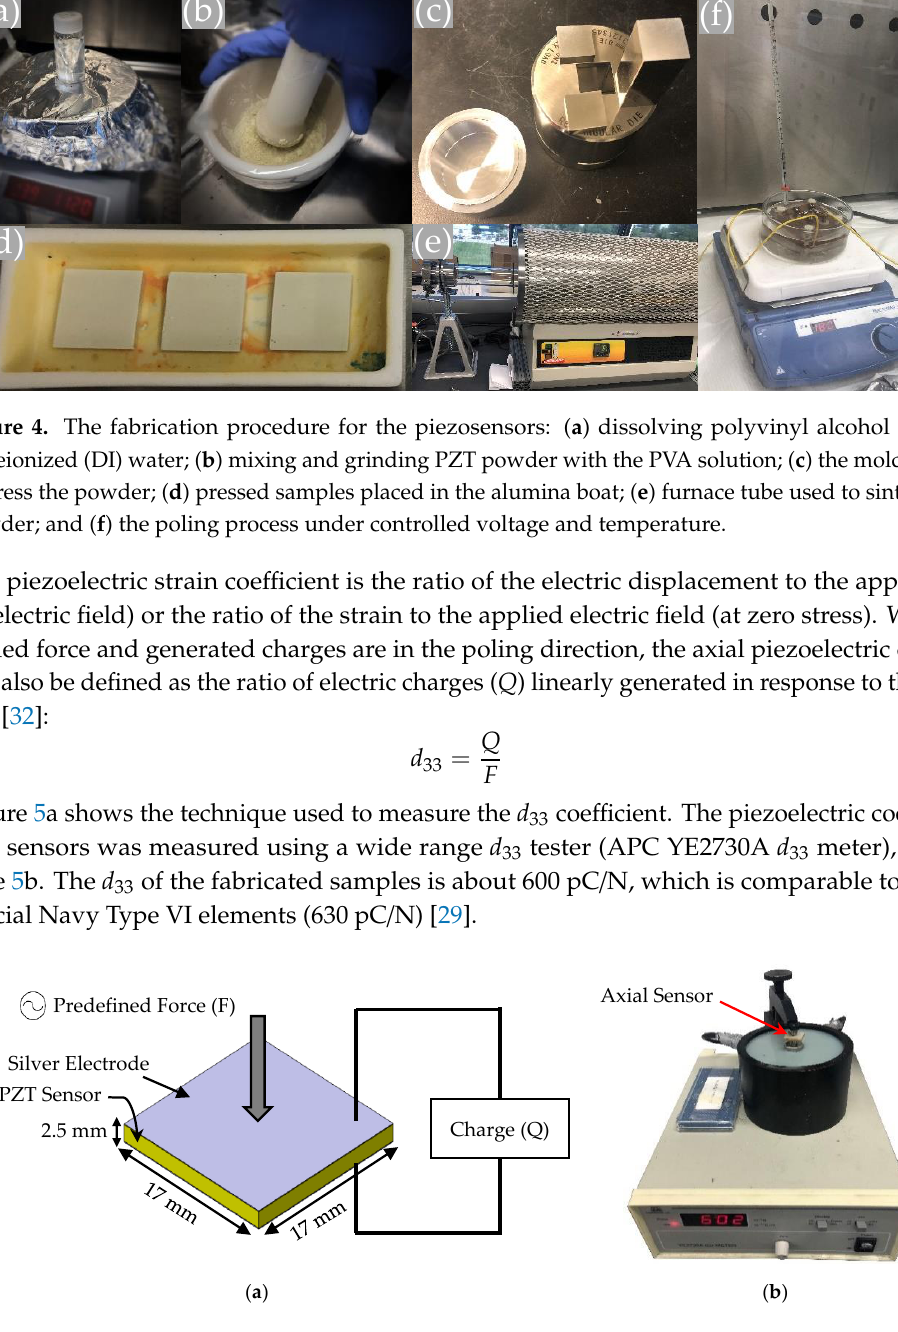
Figure 5. ( a ) The technique used to measure the piezoelectric coe ffi cient ( d 33 ). ( b ) Measurement of the piezoelectric coe ffi cient ( d 33 ) of the axial